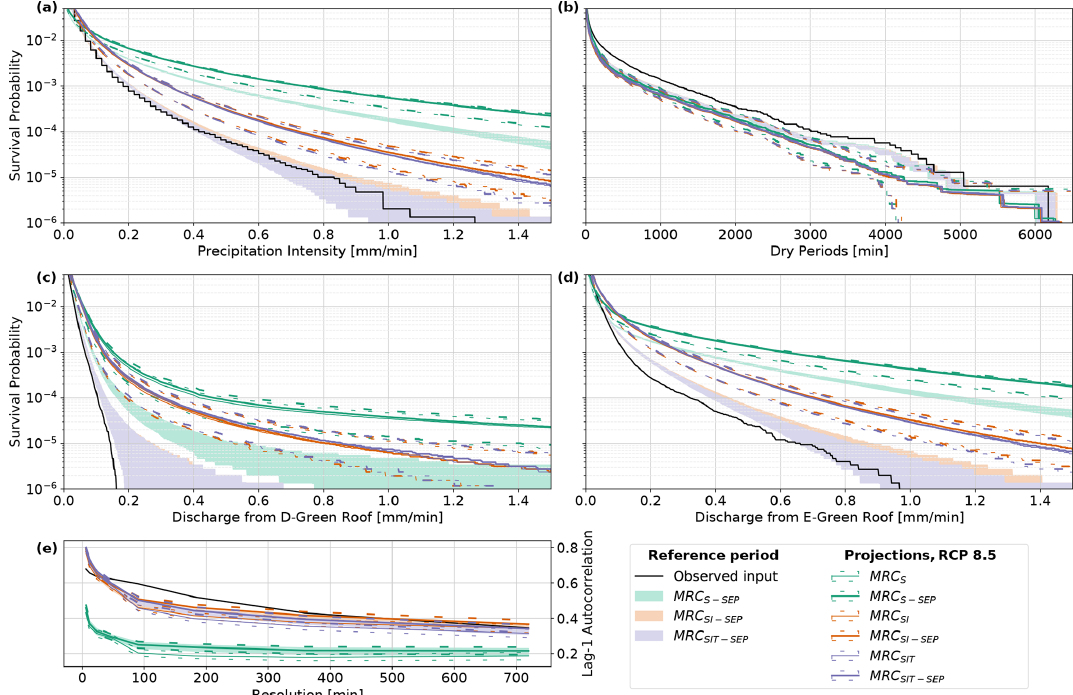
Figure 7. Comparison between performance under current climate and future climate in Bergen for the MRC S , MRC S-SEP , MRC SI , MRC SI-SEP , MRC SIT , and MRC SIT-SEP with a range from the 5th to 95th percentiles. They are compared to observed input which rep- resents the fine-resolution observed time series or simulation using this time series as input. Table 3. Retention fraction in the different locations defined as the sum of outflow divided by the sum of precipitation. Location Bergen Bodø Lyon Hamar